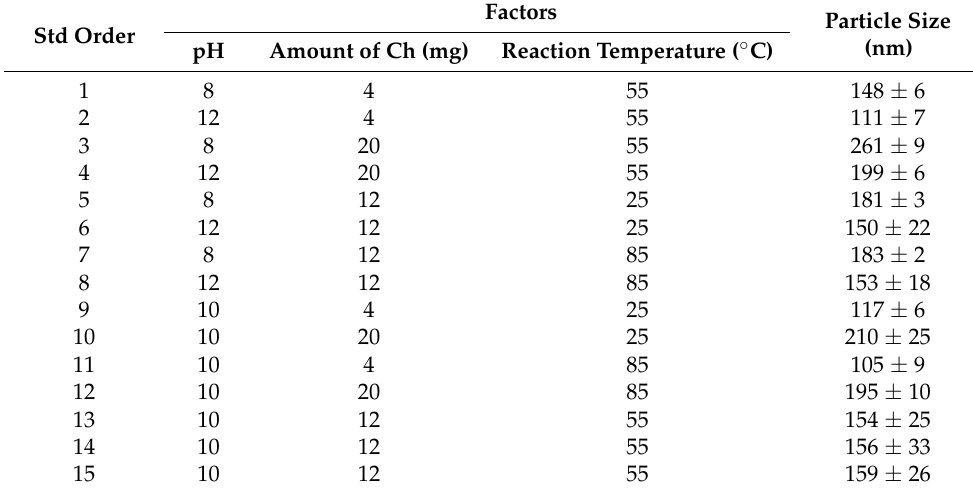
Factors Particle Size